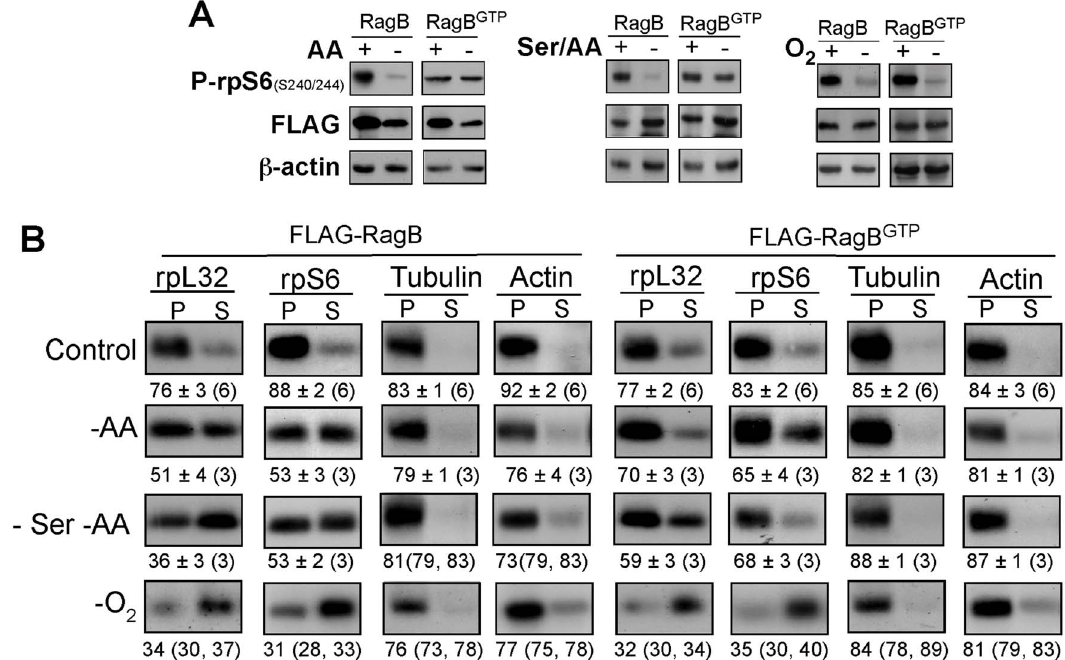
Figure 6. Overexpression of RagB GTP can derepress TOP mRNA translation in amino acid-starved cells, but not in cells deprived of oxygen. (A) HEK293 cells were infected with lentiviral expression vectors encoding FLAG-RagB or FLAG-RagB GTP . 48 h post infection cells were subjected to selection by puromycin and 48 h later were either kept untreated ( + ), amino acid-starved for 8 h ( 2 AA), amino acid starved during the last 3 h of 24 h serum starvation (–Ser/AA) or deprived of oxygen ( 2 O 2 ) for 16 h. Cells were harvested and their cytoplasmic proteins were subjected to Western blot analysis using the indicated antibodies. (B) Polysomal analysis of cytoplasmic extracts from cells treated as describe in (A).